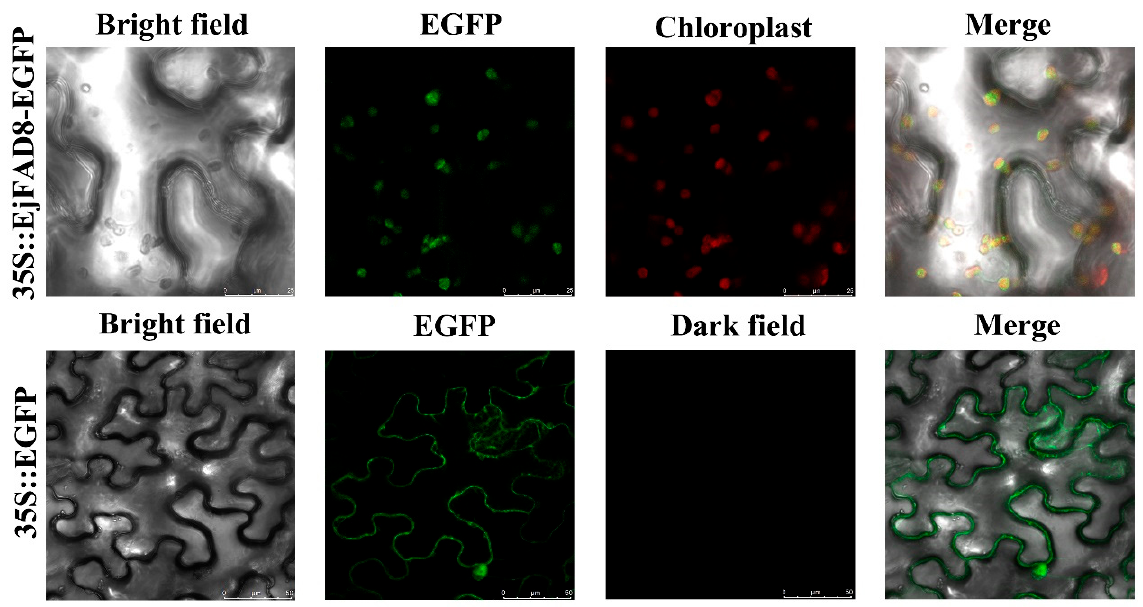
Figure 4. The subcellular localization of EjFAD8 in Nicotiana benthamiana epidermal cells. EGFP, enhanced green fluorescent protein.